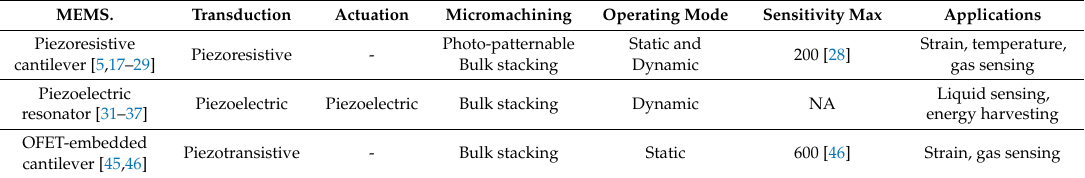
Table 1. Main characteristics of piezoresistive, piezoelectric and piezotransistive transductions.